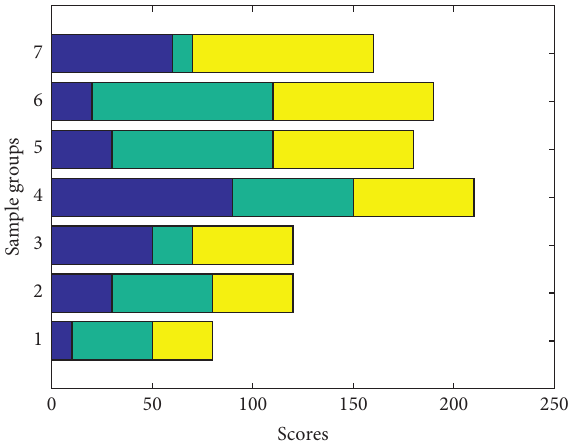
Figure 9: Performance score of each sample group of multivisual animation model.